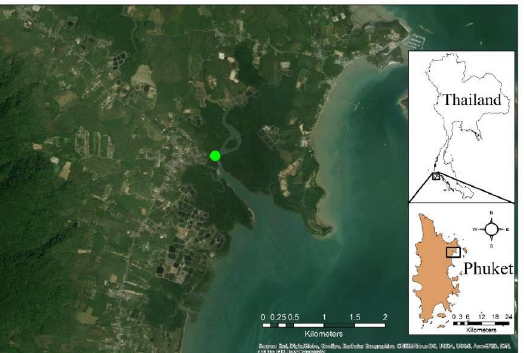
Figure 1. Location of study area. The green point is the mangrove forest tower located in Bangrong Bay, Phuket province, Thailand ( 8 . 052° N and 98 . 415° E ). To study the mangrove phenology, two Wingscapes TM time lapse RGB cameras (phenocams) were installed on a mangrove observation tower (8.052° N, 98.415° E) (Figure 2). The heights of phenocam-1 and phenocam-2 were 15 and 5 m above mean sea level, respectively. The orientation of phenocam-1 was north-facing and that of phenocam-2 faced to the west (Figure 2a). The view angles of phenocam-1 and phenocam-2 were set at 5° and 3°, respectively. The observation period was from July 2015 to August 2016, and both phenocams captured images every 30 min [36,44] from 07:00 to 16:30 local time (GMT + 07 h). The focal length was set to infinity for both phenocams. All images were saved as JPEG files and contained red (R), green (G), and blue (B) channels containing 2592 × 1944 pixels. Due to the limitations of the memory cards of the phenocams (8 Gigabyte), the data were collected during field site visits every month. Figure 2. Fields of view and orientations of the two phenocams installed in the mangrove forest tower enclosure, which protected the phenocams. ( a ) The green square represents the top view of mangrove tower roof, with the viewing directions for ( b ) phenocam-1 (north facing) and ( c ) phenocam-2 (west facing) both showing the region of interest (ROI) of the mangrove forest area (ROI 1, white rectangle), as well as the combined mangrove–water canopy (ROI 2, black rectangle),